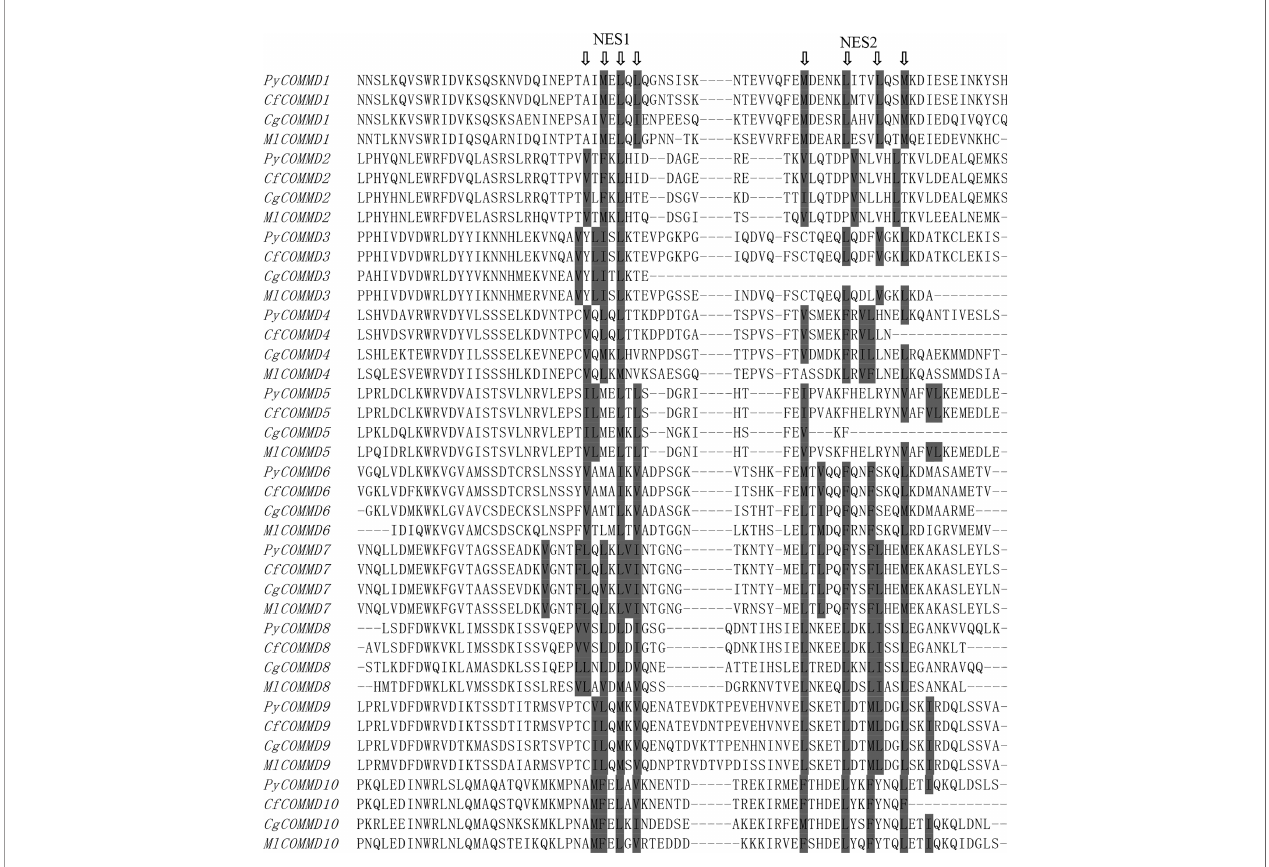
FIGURE 2 | Alignment of deduced COMM domain amino acid sequences. The two nuclear export signals (NES1 and NES2) are indicated in gray shades and by arrows pointing at conserved hydrophobic